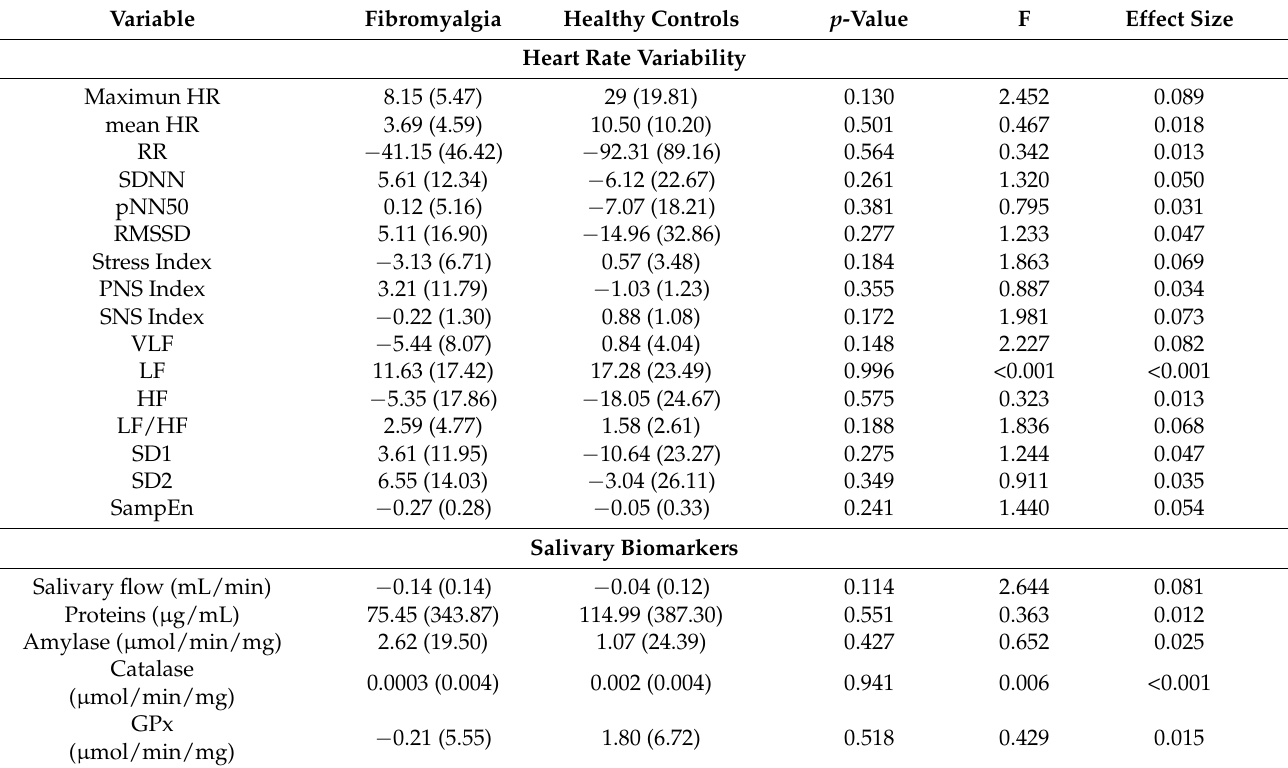
Table 4. Impact of exercise on HRV and on salivary biomarkers in people with fibromyalgia and healthy